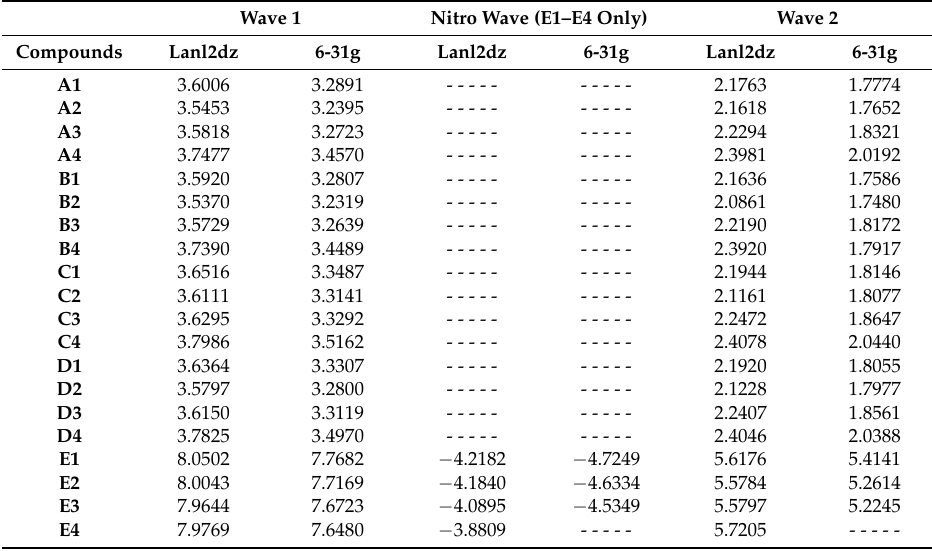
Table 2. The half-cell reaction potentials in volts for Wave 1, Nitro Wave, and Wave 2 calculated using the BYL3P DFT lanl2dz and 6-31g basis sets in Gaussian